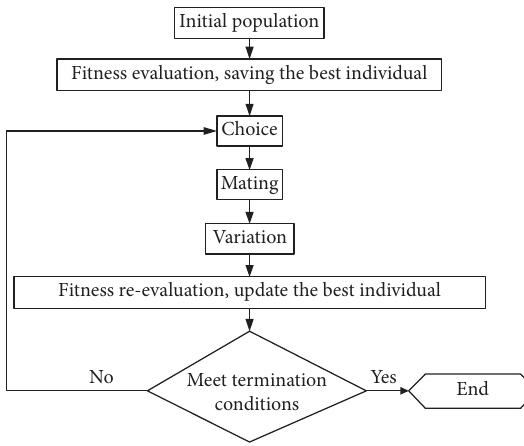
Figure 7: Flowchart of the genetic algorithm.